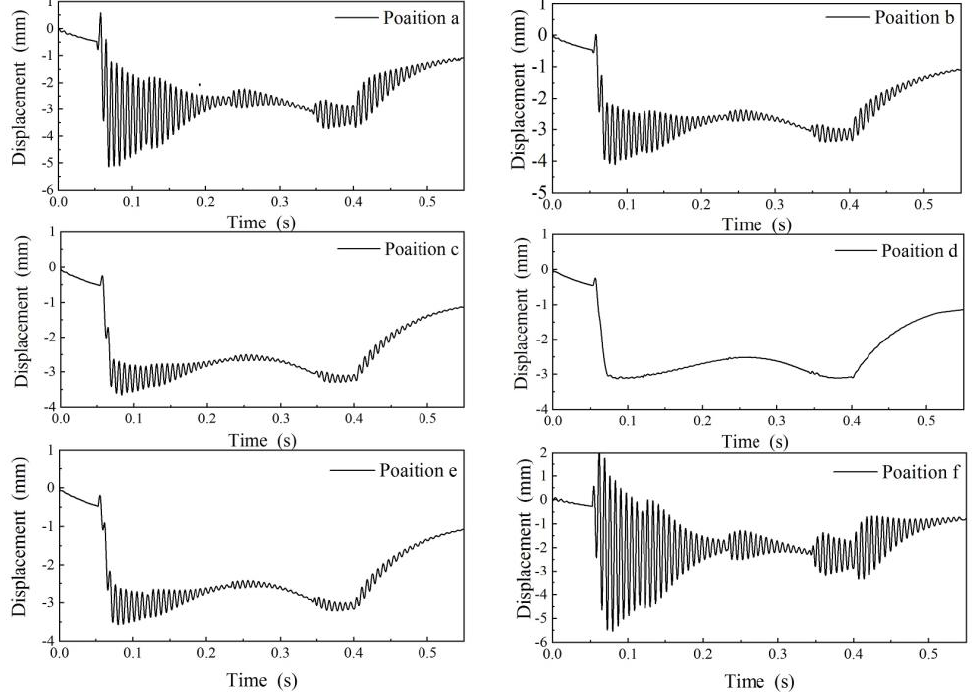
Figure 9. The motion state of the measuring ruler at different measuring positions.